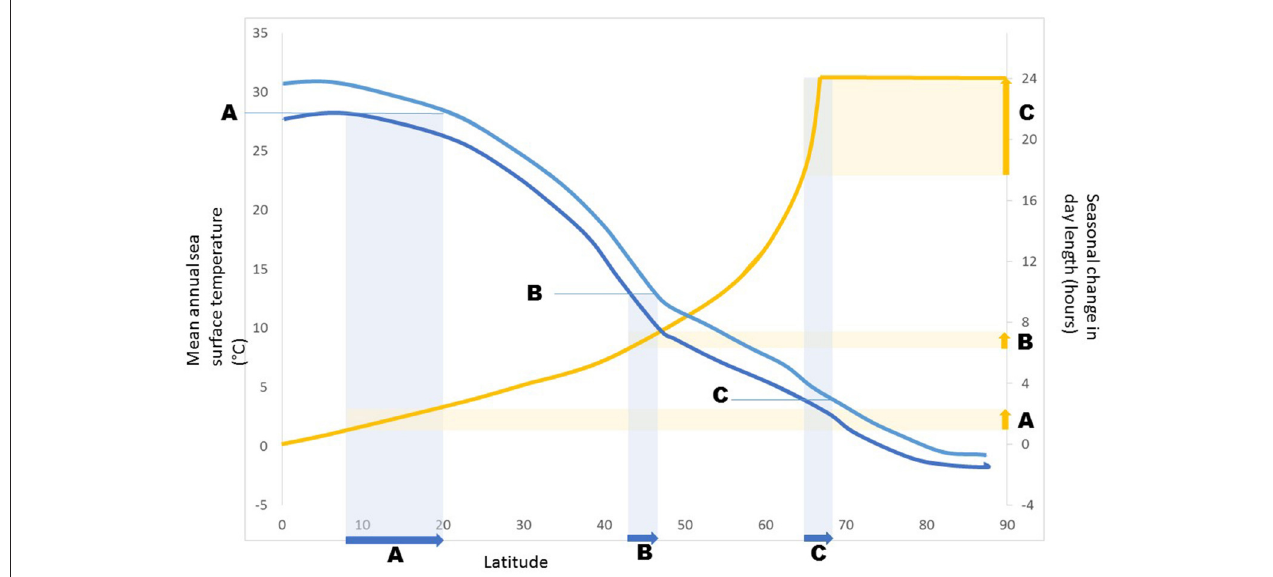
FIGURE 4 | Interaction among regional warming, latitudinal shifts, and seasonality in light for three hypothetical marine species. Dark blue line = current (1980–2005) zonal (5 ◦ latitude bands) mean annual sea surface temperature (SST) from Hadley Centre Sea Ice and Sea Surface Temperature data set (HadISST). Light blue line = future (2075–2100) zonal mean annual SST using ensemble data given in García Molinos et al. (2015). Temperature data for the Northern Hemisphere. Orange line = seasonal change in daylength, from the equator (no change) to polar seas (24h daylight in summer to 0h in winter) modified from Saikkonen et al. (2012). The shaded areas and arrows indicate shifts in latitude and daylength experienced as a species tracks its thermal niche. Species A lives in the tropics (29 ◦ C), to track its thermal niche requires a relatively large latitudinal shift ( > 10 ◦ ) but experiences an intermediate change in light seasonality ( ∼ 1 h). Species C is a sub-polar species (4 ◦ C), it requires an intermediate shift in latitude ( ∼ 3 ◦ ) to track its thermal niche but experiences a large change in light seasonality over this distance ( > 7 h). Species B lives in temperate regions (13 ◦ C) and experiences an intermediate change in light seasonality ( < 1 h) over an intermediate change in latitude ( ∼ 3 ◦ ) as it shifts distribution to track